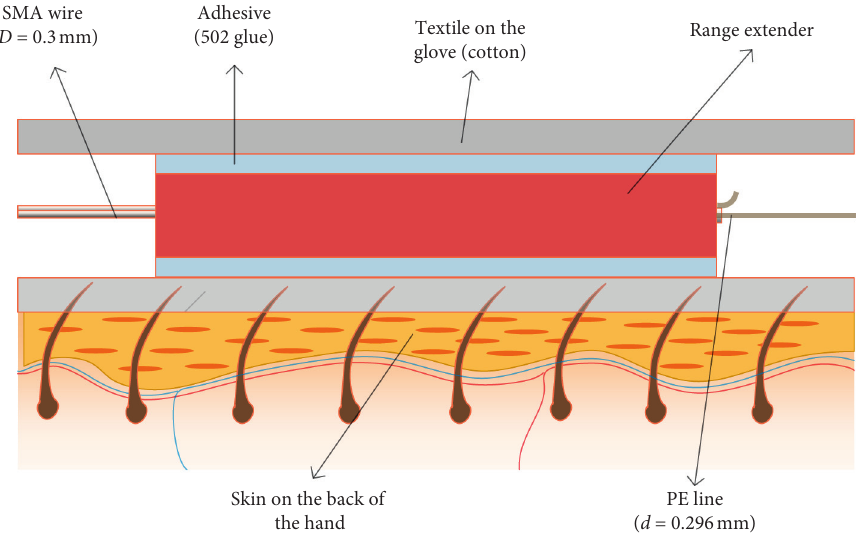
Figure 4: Schematic diagram of the hierarchical